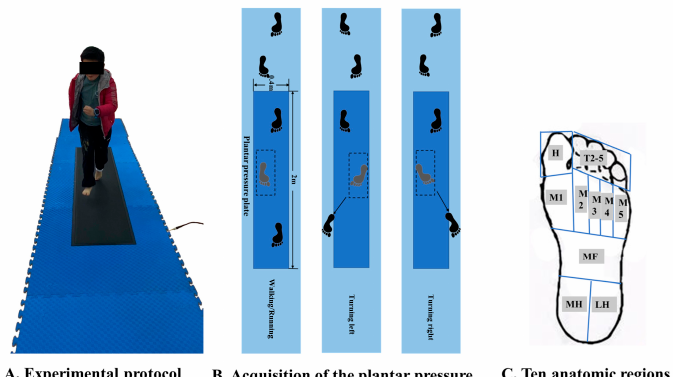
Figure 1 . Illustration of the test protocol of straight running ( A ) and left and right turning ( B ) and division of anatomic regions ( C ).